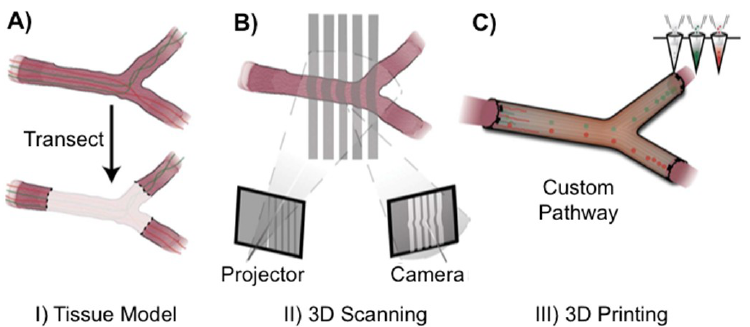
Figure 1. Schematic representation of 3D printing, ( A ) transection of complex nerve ( B ) Imaging of transected nerve ( C ) functionalization of the 3D printed model with physical cues, and path-specific biochemical cues. Adapted with permission from ref. [31]. Copyright 2015, Wiley-VCH.